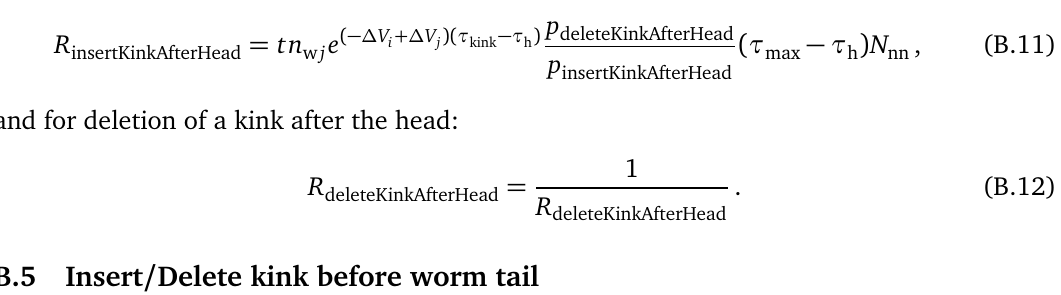
Figure 19: Insert / Delete kink before tail. A kink is inserted between neighboring sites i , j before the worm tail at a randomly sampled time τ tail moved to the site where the particle hops from. The lower bound of the sam- pling interval τ is chosen to be the largest out of the two lower bounds of the min corresponding flat intervals. This ensures that the new kink does not interfere with other kinks, which simplifies the implementation. The complementary update is to delete the kink and move the tail back to the site from where the particle is hopping